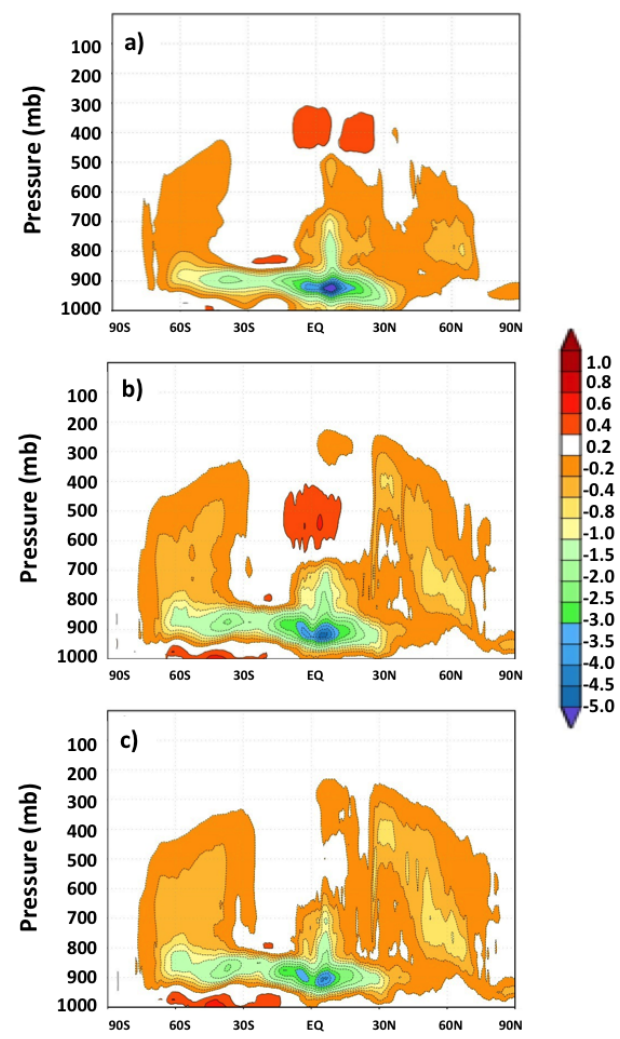
Figure 19. June-July-August seasonal mean change in moisture due to moist processes in kgm − 2 day − 1 from MERRA2-like AGCM for (a) 1-degree resolution, (b) 1 / 2-degree resolution, (c) 1 / 4-degree